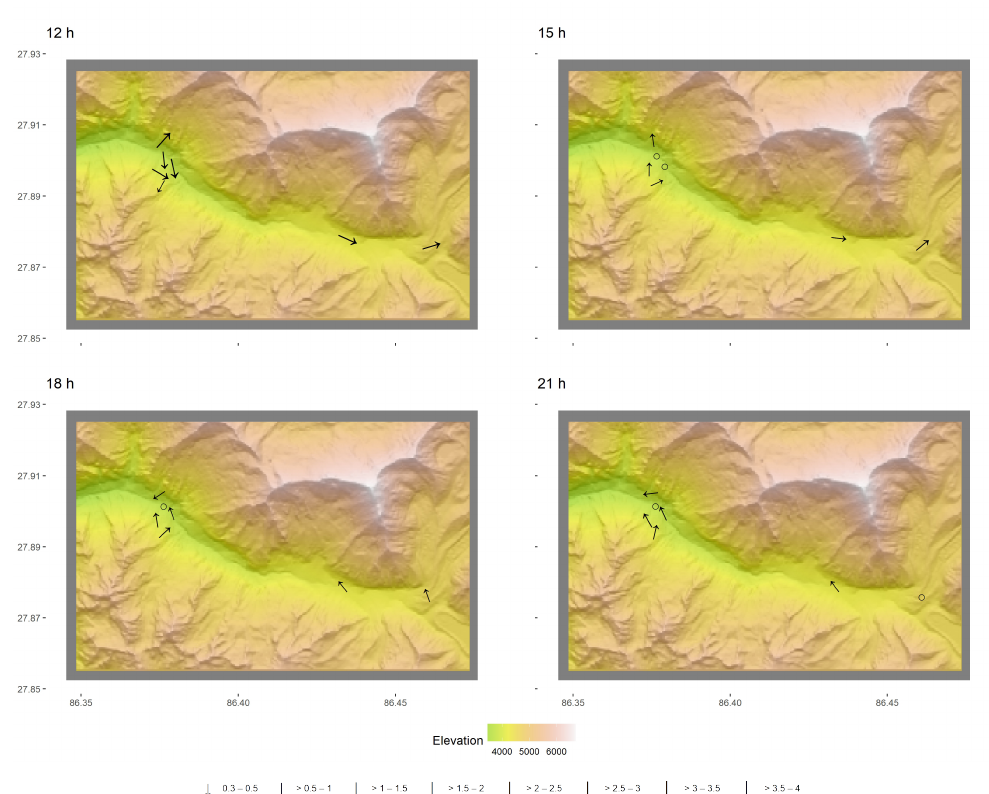
Figure 8. Diurnal forming of the winds in the Rolwaling Valley on 22 November 2017. Sub-figures showing the mean hourly wind speeds of the first hour of the day (12:00–13:00) in the top-left. The hour between 15:00 and 16:00 at the top-right, and the hours following 18:00 and 21:00 in the bottom row left and right respectively. Arrows indicate the wind direction at the stations, with the wind speed shown by the size of the arrow. Calm hours and hours with less than 0.3 m s − 1 are indicated by